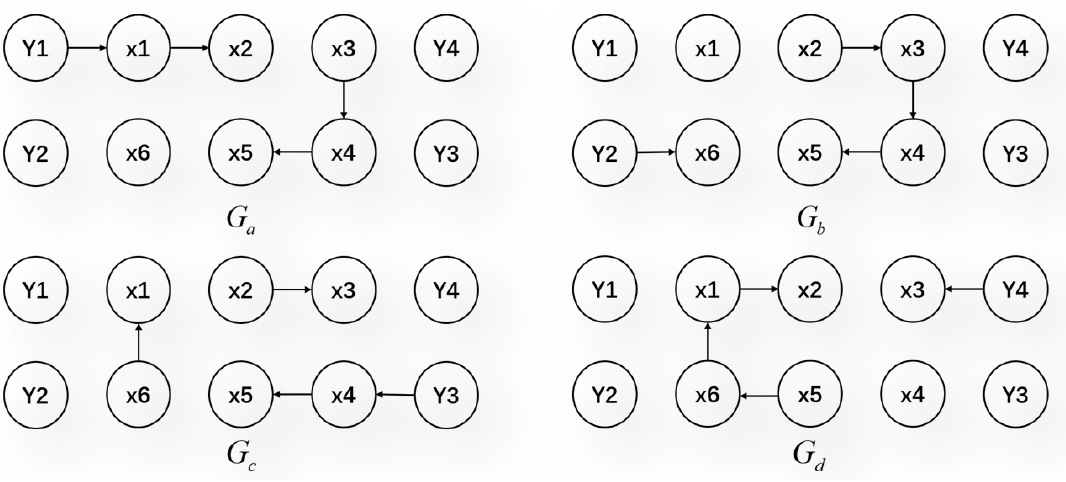
Figure 3. Switching graphs.